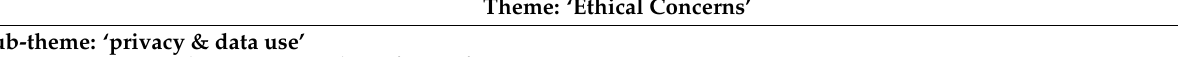
Table 6. Representative quotes relating to the theme ‘ethical concerns’. Theme: ‘Ethical